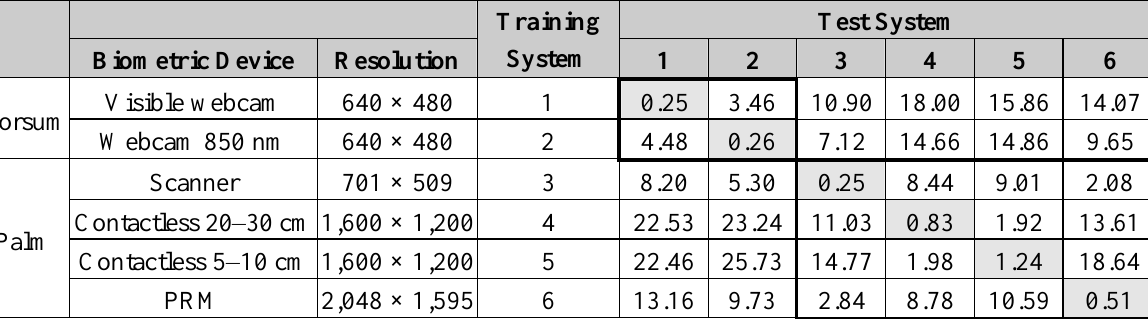
Table 6. Interoperability matrix for Finger-Geometry approaches with smoothing in terms of EER